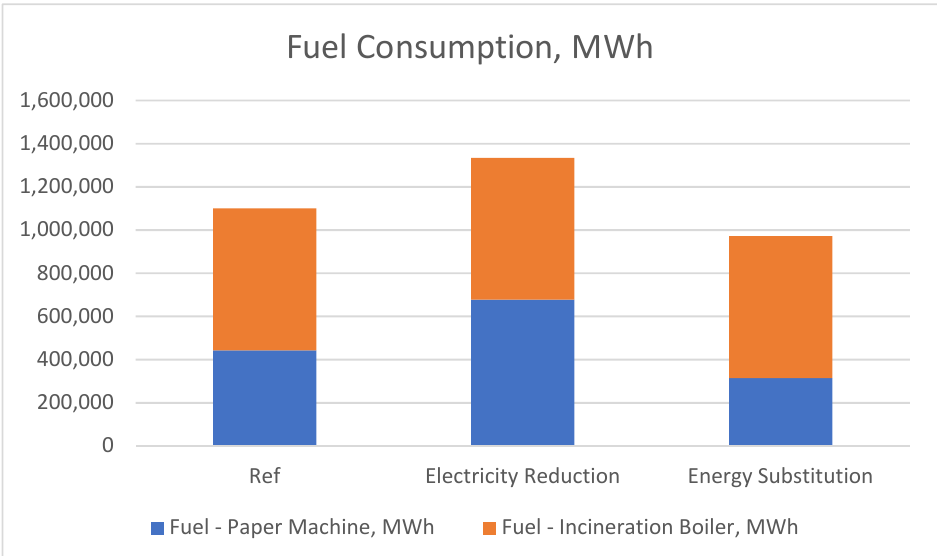
Figure 3. The fuel consumption (biofuel) for each case.